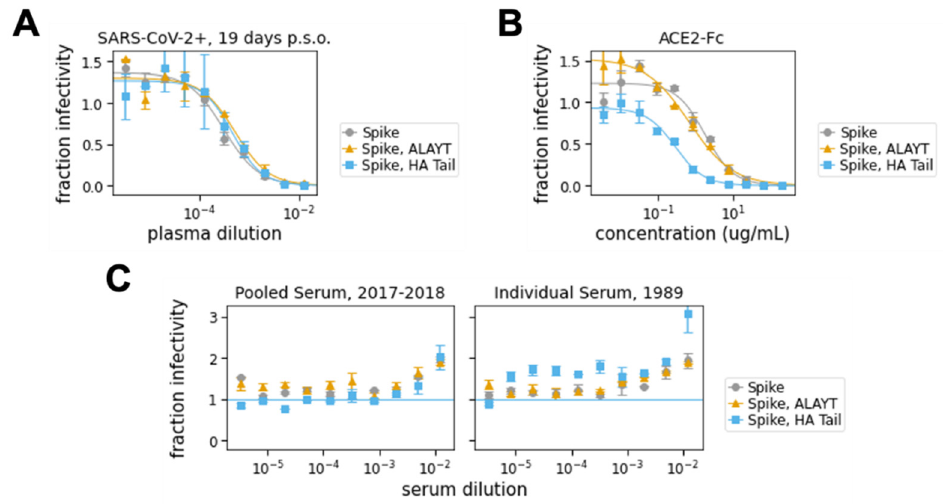
Figure 4. Neutralization assays. ( A ) Neutralization assay using plasma collected from a confirmed SARS-CoV-2-infected patient at 19 days post-symptom onset (“p.s.o.”). The IC50 for this plasma was 1:2076 for the Spike-pseudotype, 1:1334 for the Spike-ALAYT-pseudotype, and 1:1605 for the Spike, HAtail-pseudotype. ( B ) Neutralization assay using soluble ACE2 protein fused to the Fc domain from IgG (ACE2-Fc). The IC50 for ACE2-Fc was 2.49 µ g / mL for the Spike-psdeudotype, 1.75 µ g / mL for the Spike-ALAYT-pseudotype, and 0.25 µ g / mL for the Spike-HAtail pseudotype. ( C ) Negative control sera collected prior to the emergence of SARS-CoV-2 did not neutralize the Spike-pseudotyped lentiviral particles. The serum from 1989 was from a person of a similar age at the time of serum collection as the confirmed SARS-CoV-2 infected patient whose plasma was tested in A . High concentrations of naïve serum seemed to enhance luciferase signal, perhaps because of components that improve cell-growth. Each point shows the average of duplicate values with error bars showing standard error.